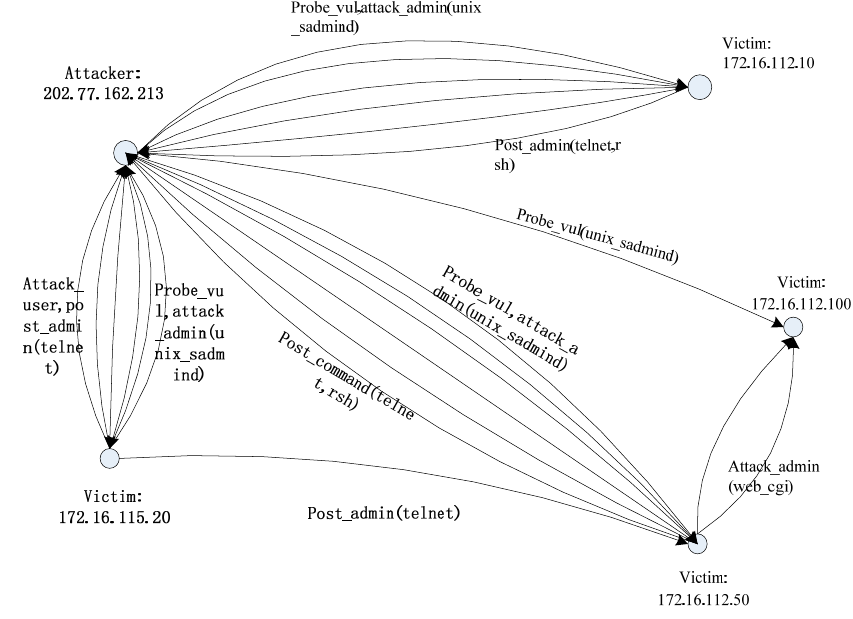
Figure 9. Wang’s LLDOS 1.0 Dataset Evidence Graph (Omission of DDoS Attack).